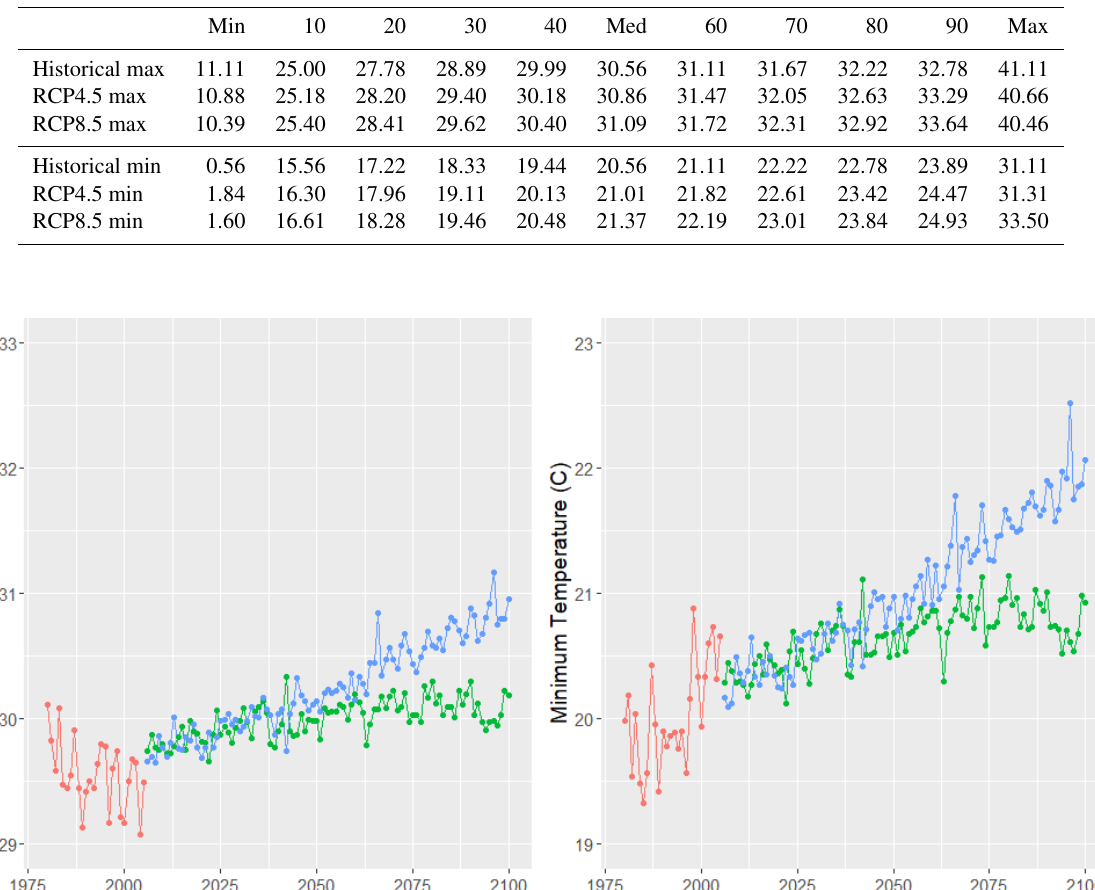
Table B1. ESM2G maximum daily temperature quantiles ( ◦ C, top panel) and minimum daily temperature quantiles ( ◦ C, bottom panel) for the observed historical (from GHCN) climate, the downscaled RCP4.5 climate, and the downscaled RCP8.5 climate.